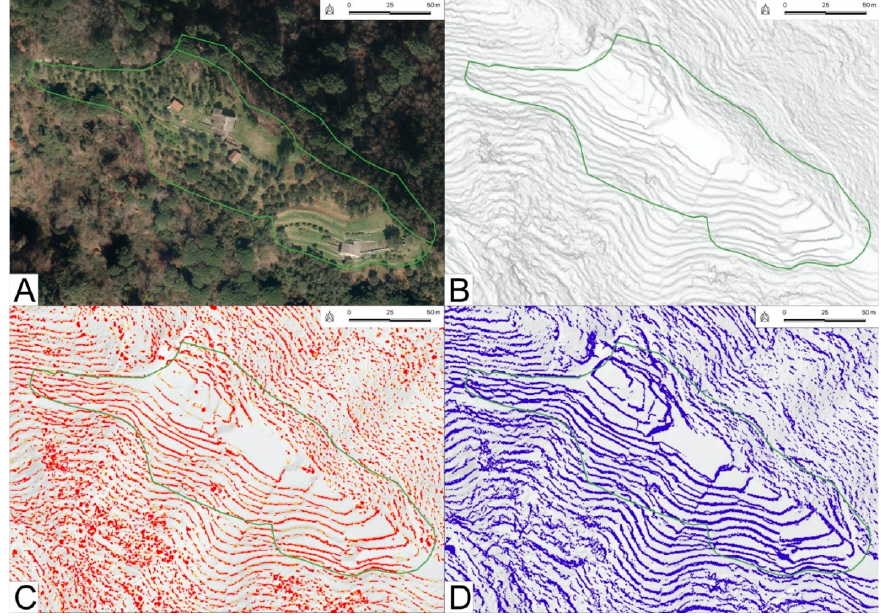
Figure 6. Terrace identification error assessment (refer to Figure 1). ( A ) The green-bordered polygons show the test areas: in the southern one, terraces are present, while in the northern one, terraces are absent. The other figure parts show terrace features obtained through the three methodologies: in ( B ) SKF, in ( C ) LUC and in ( D ) LIHA.